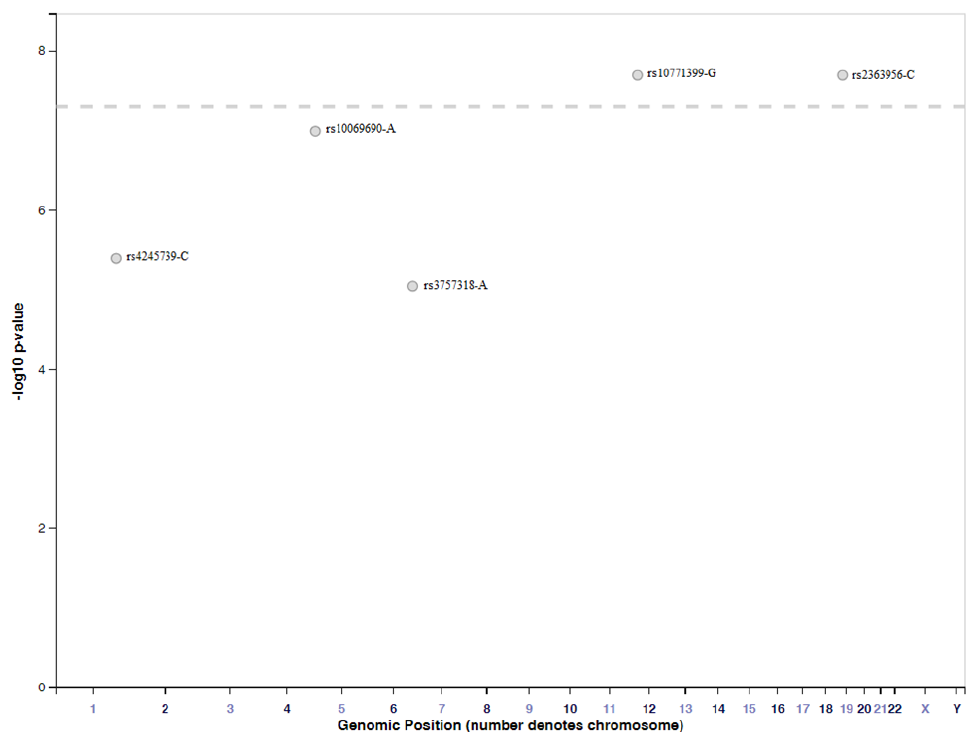
Figure 3. Schematic representation of SNPs associated with triple negative breast cancer obtained from the EMBL-EBI GWAS catalogue. Abbreviation: SNPs- single nucleotide polymorphism, EMBL-EBI, The European Bioinformatics Institute.